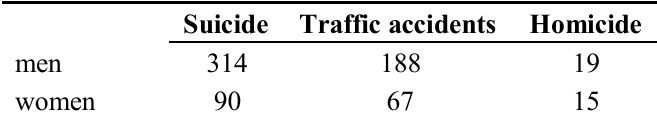
Table 3. Years of Life Lost (YLL) due to suicide, traffic accidents and homicide per 100,000 inhabitants in